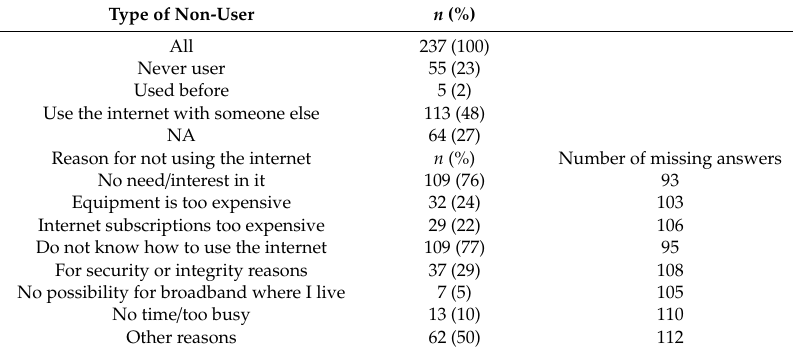
Table 4. Type of non-user and reason for not using the internet among non-users (more than one reason per person is